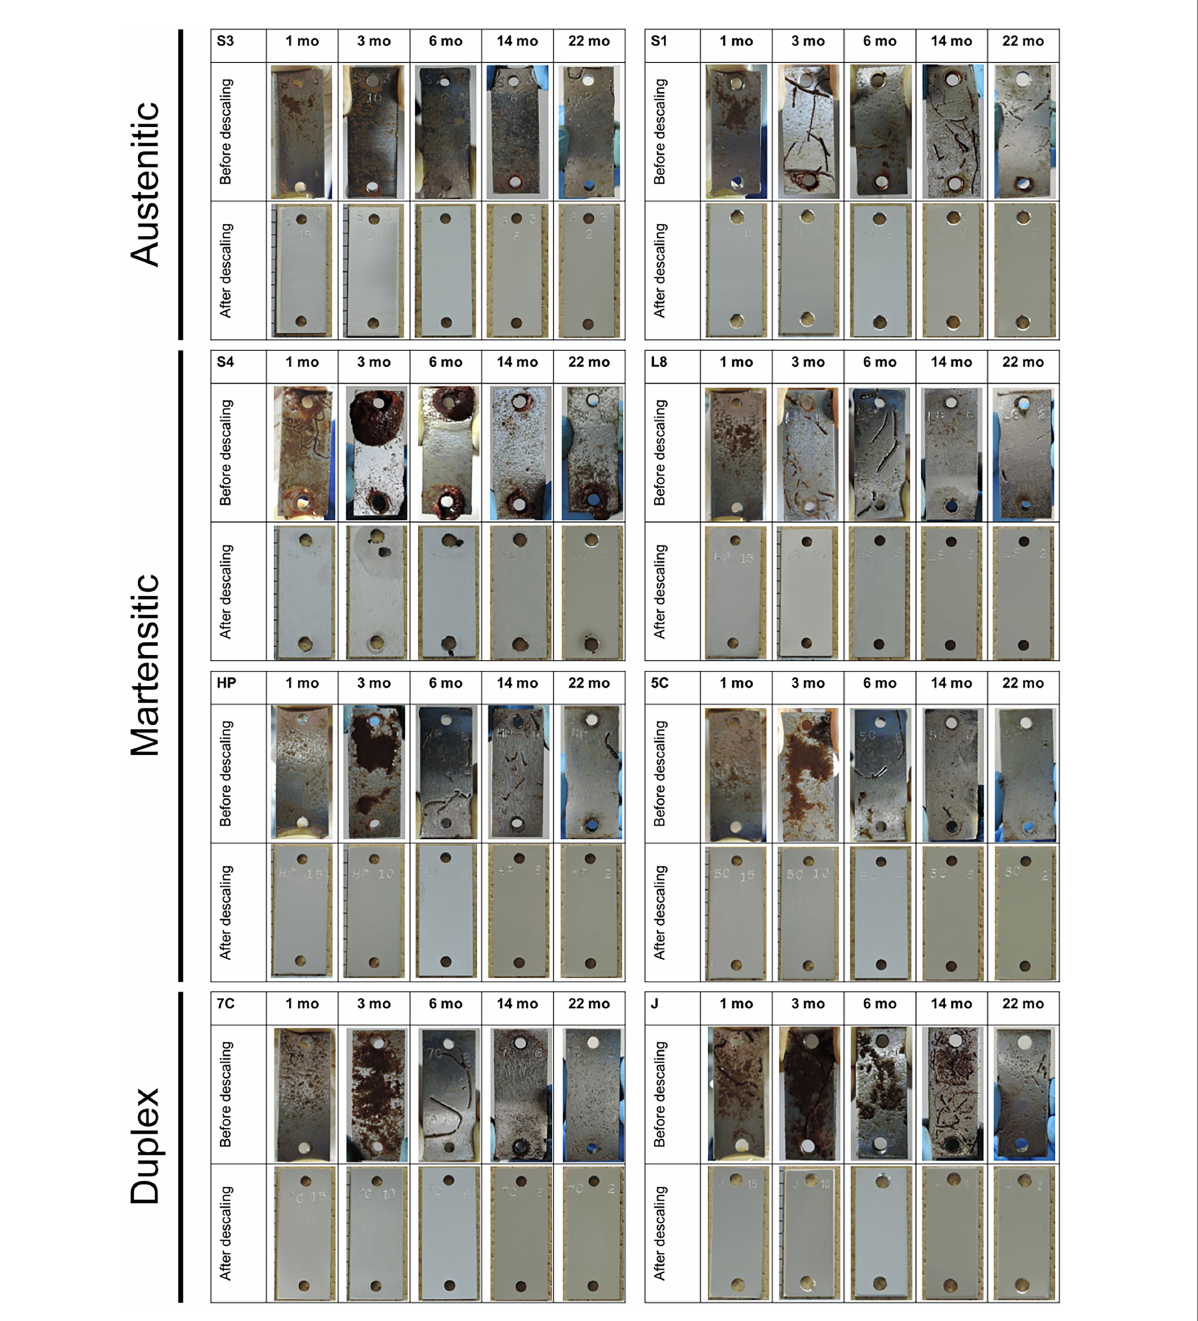
FIGURE 1 Coupons after immersion study. Macroscopic images of each coupon (50 mm high × 20 mm wide) are shown before and after descaling. S1, Casting S31600; S3, S30300; S4, S40300; L8, S42000; HP, S41426; 5C, 15% Cr; 7C, 17% Cr; and J,